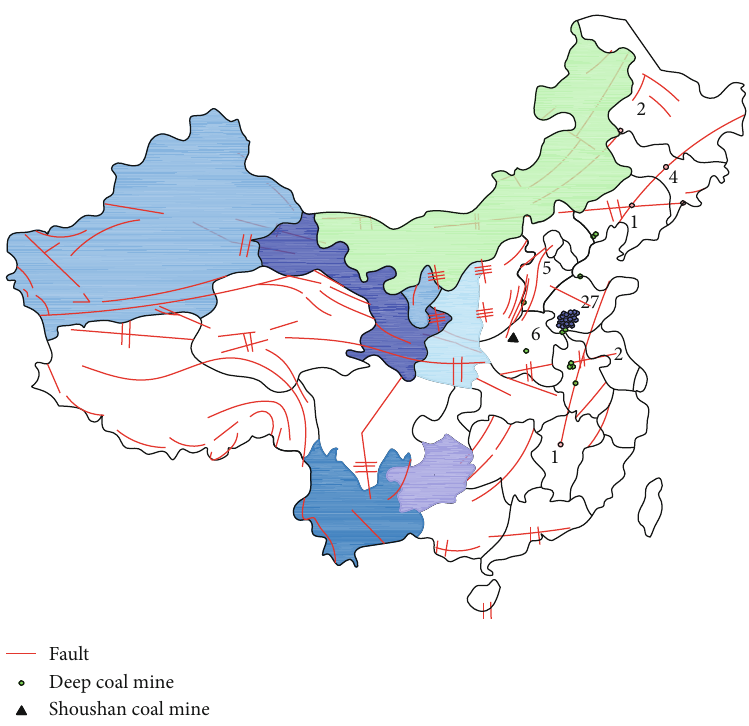
Figure 1: Distribution of coal mines with a depth of more than 1000 m in